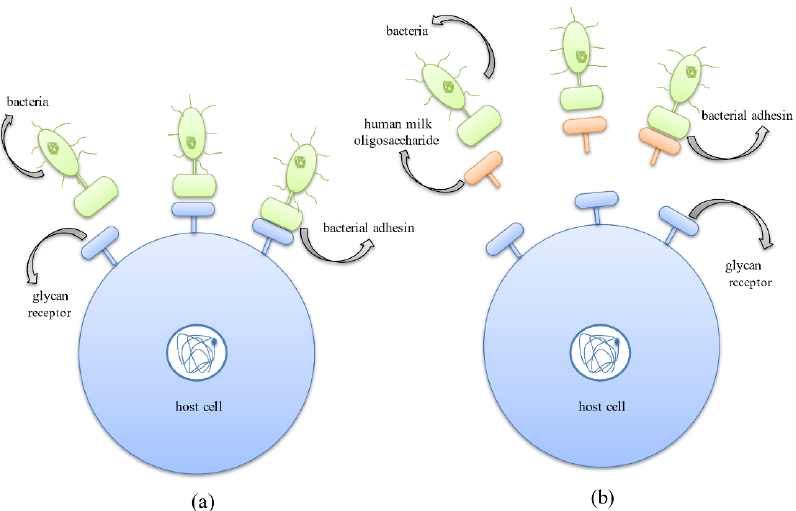
Figure 5. Anti-adhesive mechanism exhibited by HMOs where they behave as soluble decoy re- ceptors, inhibiting bacterial adhesion to host cell surface receptors. ( a ) Binding of bacterial protein adhesins to the host cell surface glycan receptors, aiding successful colonization in the host system. ( b ) Binding of bacterial protein adhesins to HMOs thus inhibiting adhesion to host cells and suc- cessfully preventing the occurrence of infection.